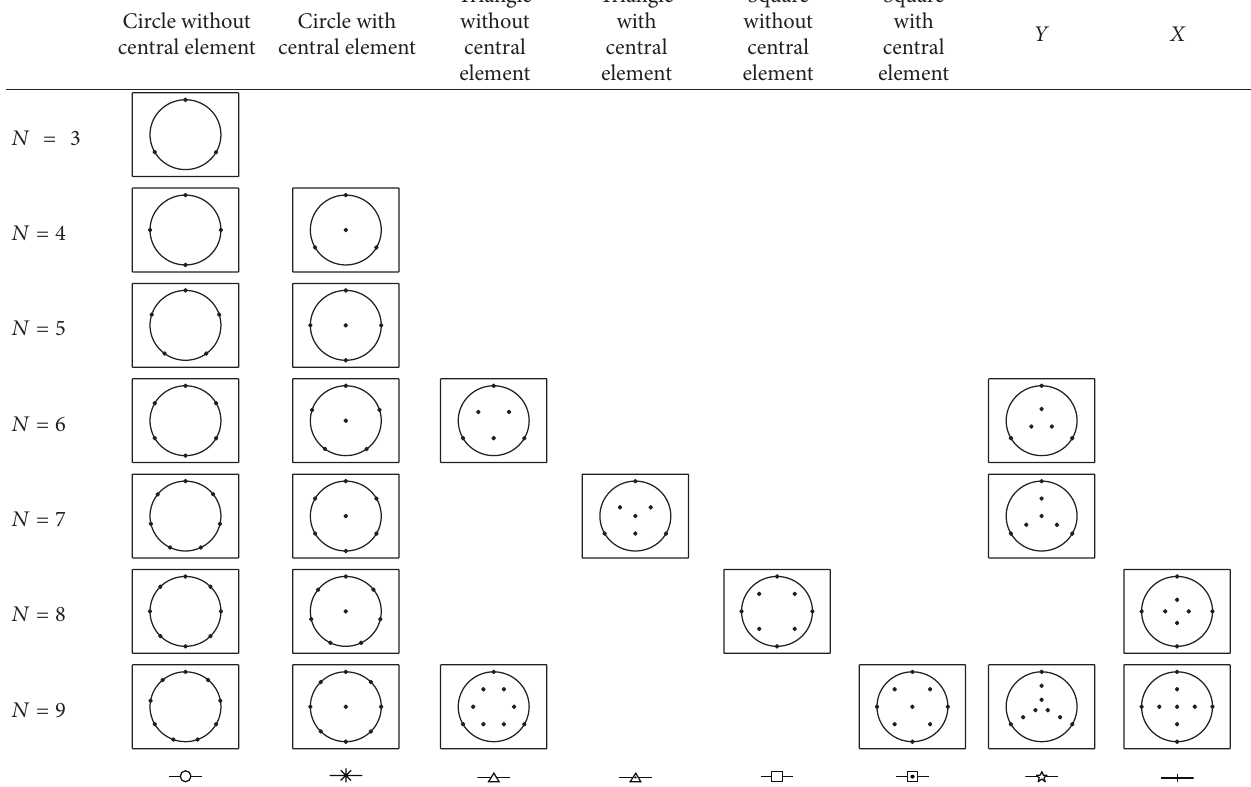
Table 1: Symmetric configurations belonging to the different classes for 𝑁 < 10 . Circle